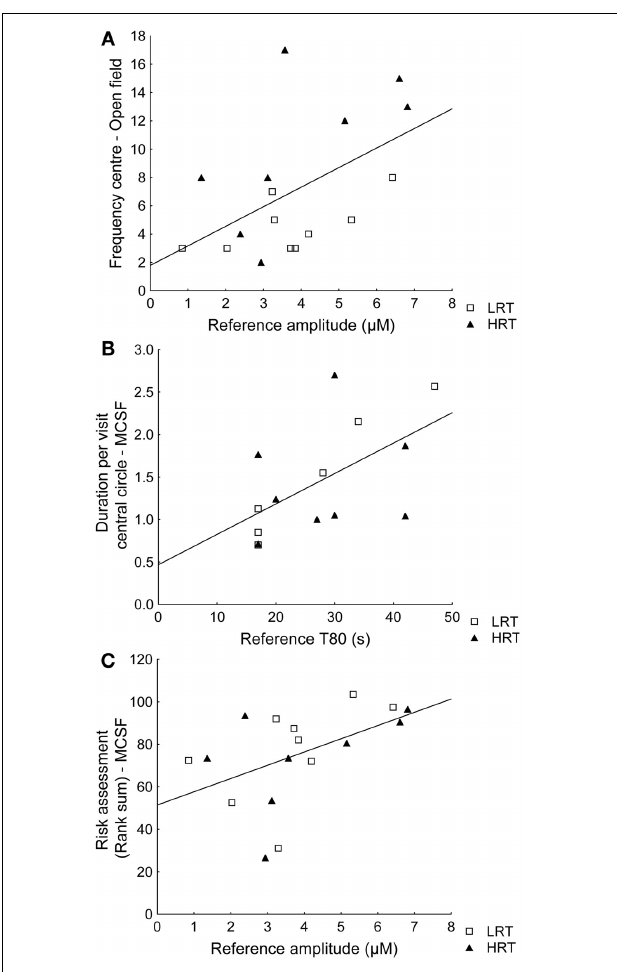
FIGURE 4 | Spearman rank order correlations in the low (LRT, N = 9) and high risk taking (HRT, N = 8) animals between (A) amplitudes and the frequency in the center of the open field test [ ρ = 0 . 49; p = 0 . 045], (B) T80 values and the duration/frequency in the central circle of the multivariate concentric square field™ (MCSF) test [ ρ = 0 . 60; p = 0 . 023], and (C) the risk assessment rank sum from the trend analysis of the MCSF test [ ρ = 0 . 58; p = 0 .